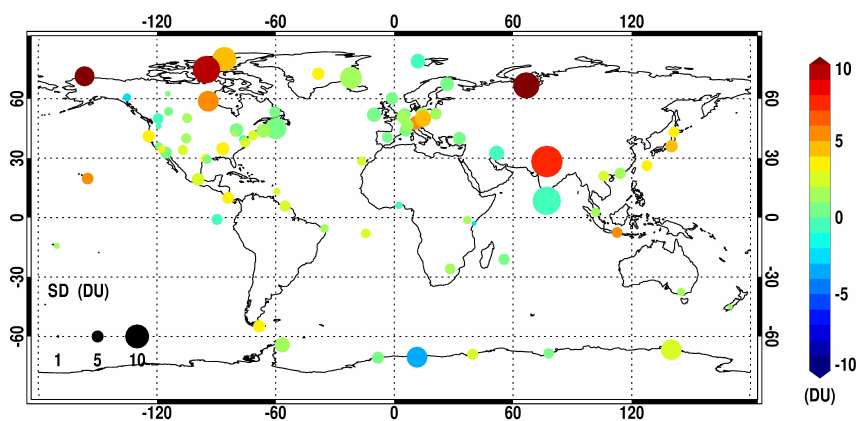
Figure 2. The distribution of ozonesonde stations in this study. The color represents the mean biases between OMI and ozonesonde tropo- spheric ozone columns (TOCs) at each station (if the number of OMI and ozonesonde pairs is more than 10), and the dot size represents the standard